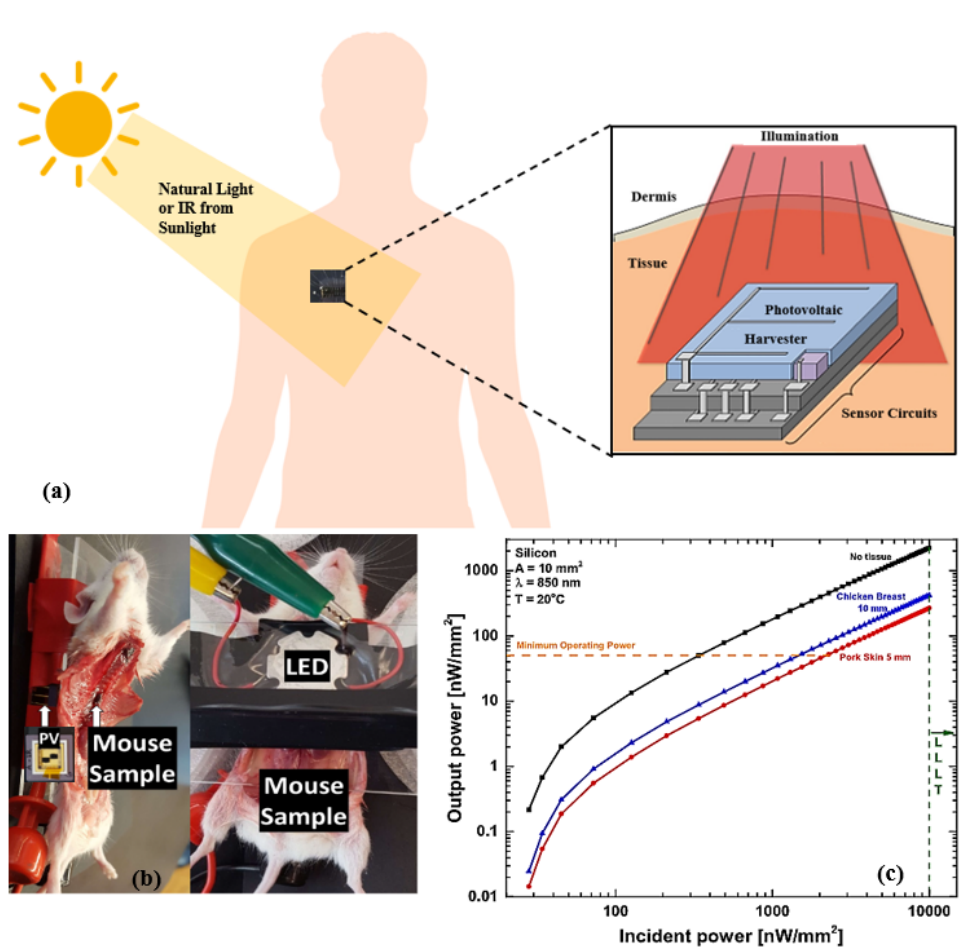
Figure 6. ( a ) Schematic of photovoltaic energy harvesting through subcutaneous tissue. ( b ) NIR energy measurement from photovoltaic cells implanted in mouse. ( c ) Incident versus output power of a silicon photovoltaic cell implanted at a 5 mm depth in porcine skin and a 10 mm depth in chicken breast using low-level laser therapy. Adapted with permission from [192]. Copyright 2017